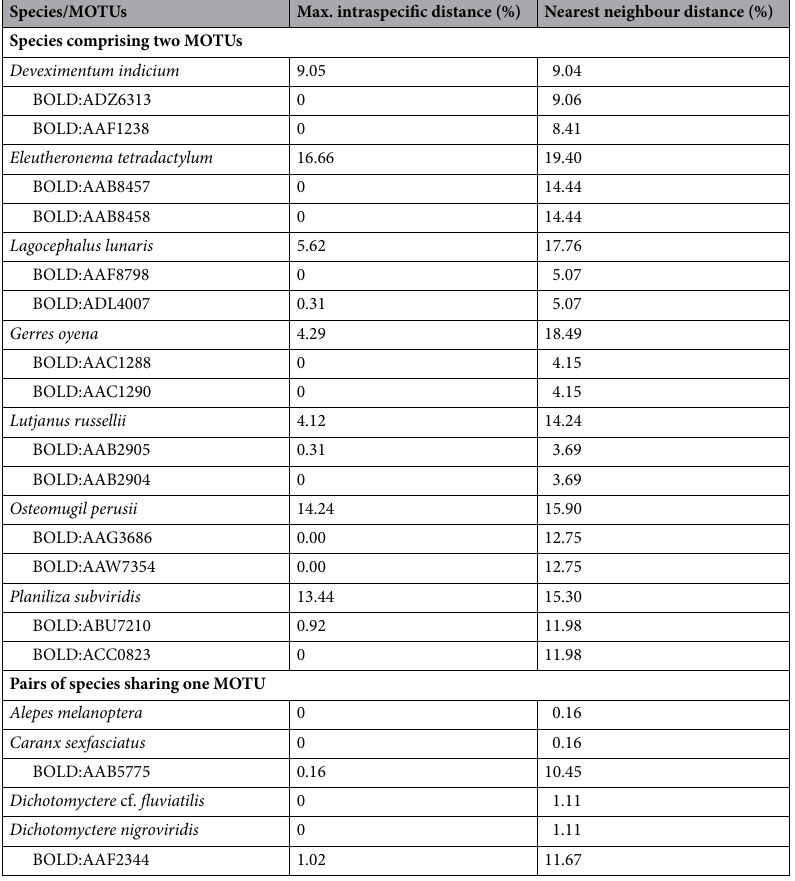
Table 3. List of morphological species comprising two MOTUs (= BINs) or sharing one MOTU. The summary statistics include the BIN of each MOTU, their maximum intraspecific distance and distance to the nearest neighbour (i.e. minimum interspecific distance).